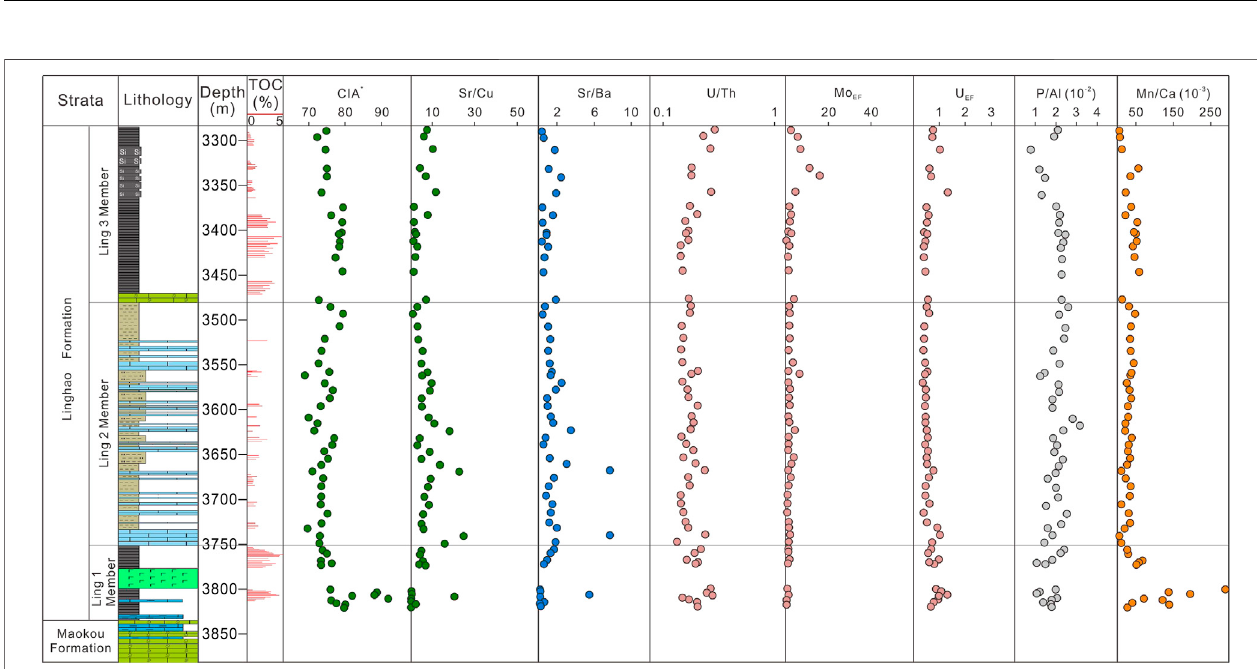
FIGURE 8 | TOC and trace elements ratios for Linghao Formation marine shale from the studied well in the central Nanpanjiang basin.